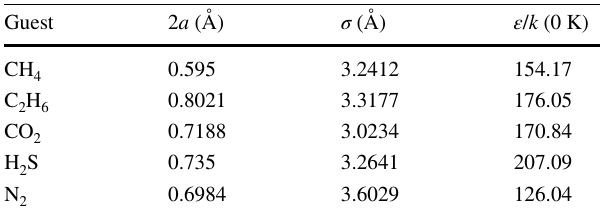
Table 3 (CH 4 hydrate) Kihara parameters for hydrate–gas interaction,